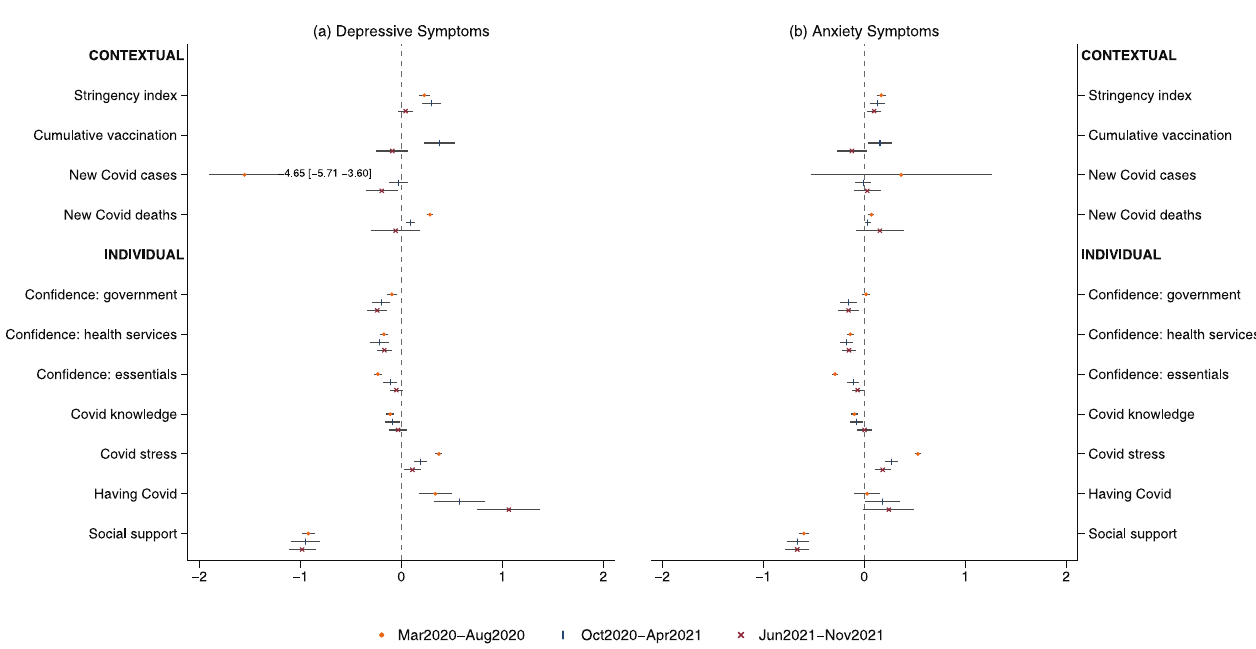
Fig 2. Estimated coefficients and 95% CIs from FE models of 3 time periods during the COVID-19 pandemic. Notes: The estimates for new COVID case from models on depressive symptoms were on a different scale compared to other predictors in order to fit into the figure without changing the x-axis scale. CI, confidence interval; COVID-19, Coronavirus Disease 2019; FE,